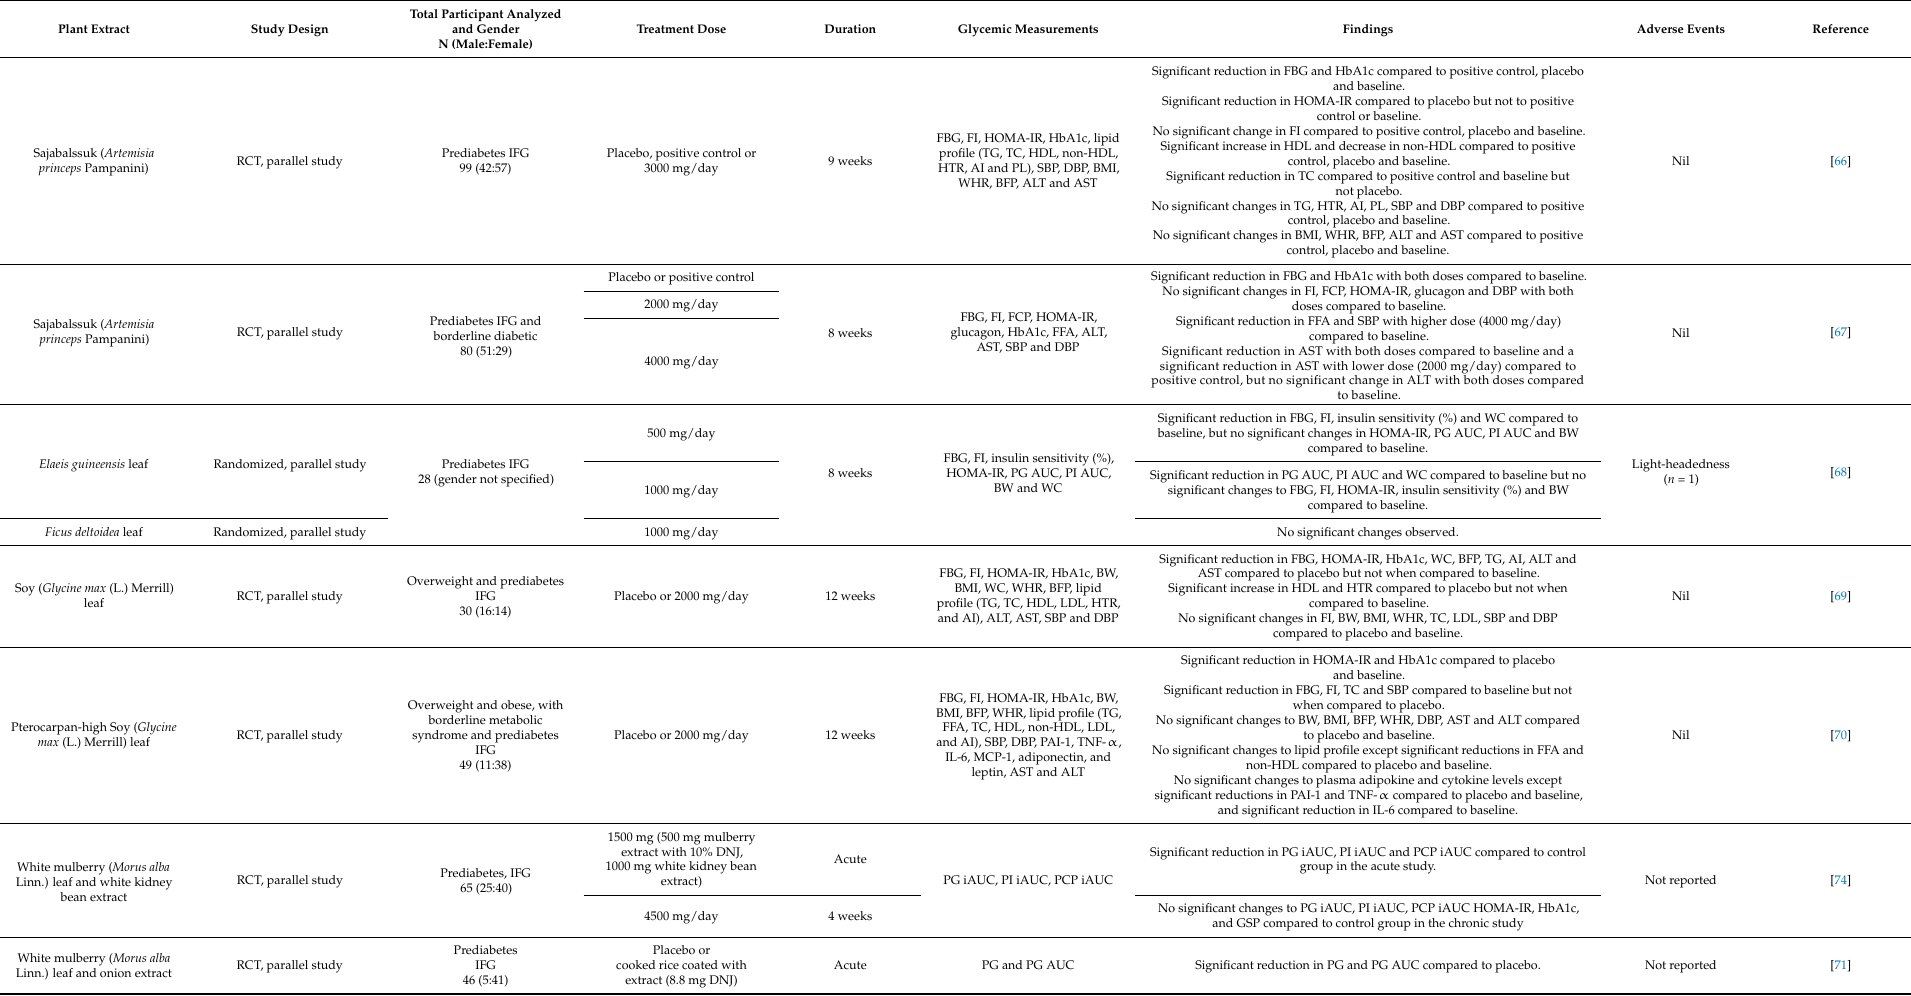
Table 1. Human clinical trials involving plant extracts and their hypoglycemic impact in participants with